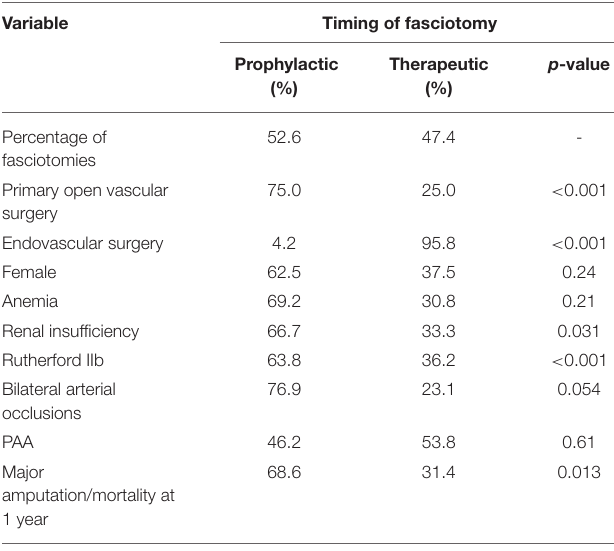
TABLE 4 | Uni-variable analysis of factors associated with prophylactic or therapeutic fasciotomy after revascularization for ALI. Variable